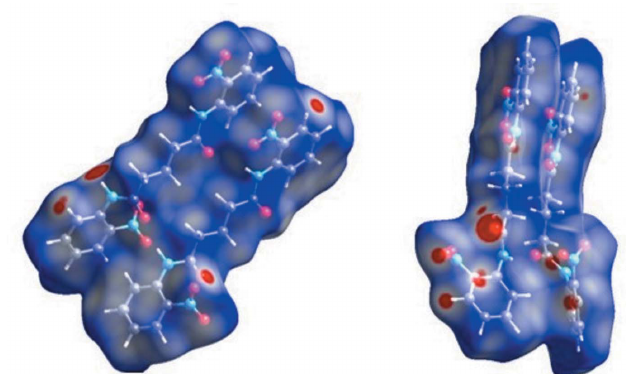
Figure 4 View of the Hirshfeld surface mapped over d norm for the two independent molecules ( A and B ). The colour scale is between (cid:4) 0.21 au (red) to 1.2 au (blue).